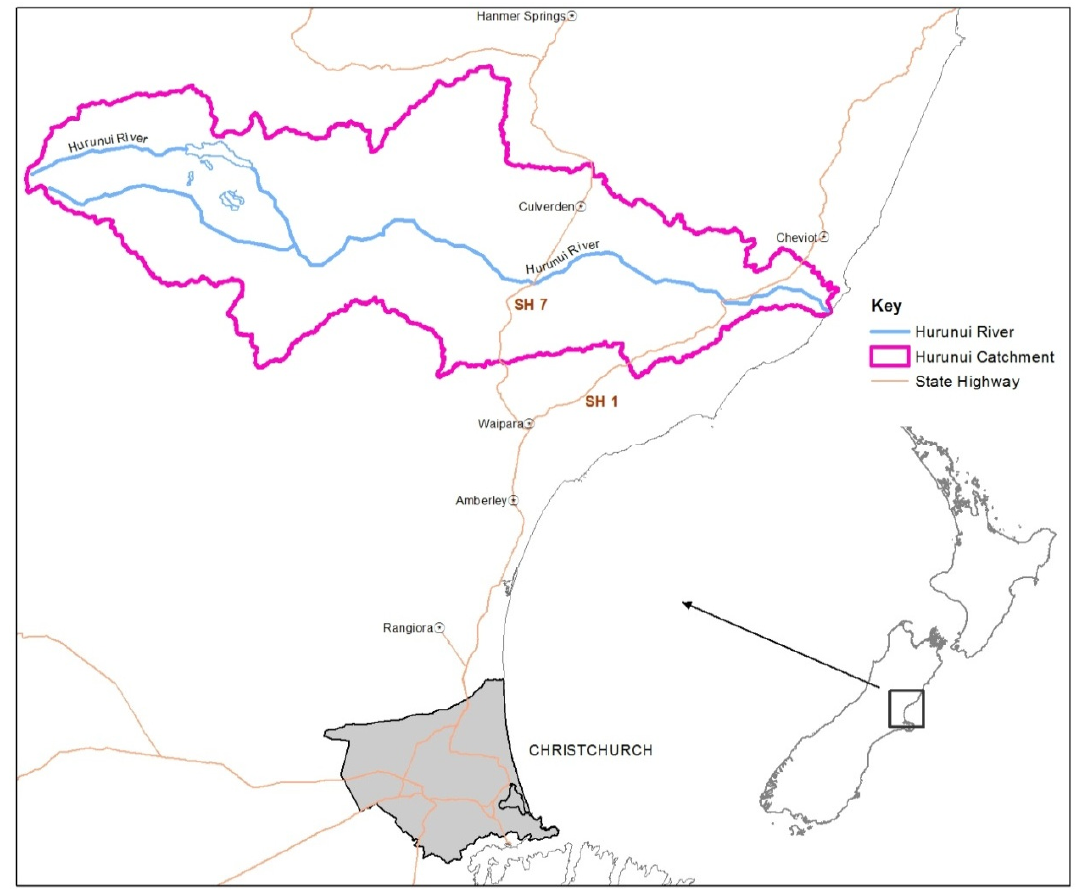
Figure 1. Location of the Hurunui River and